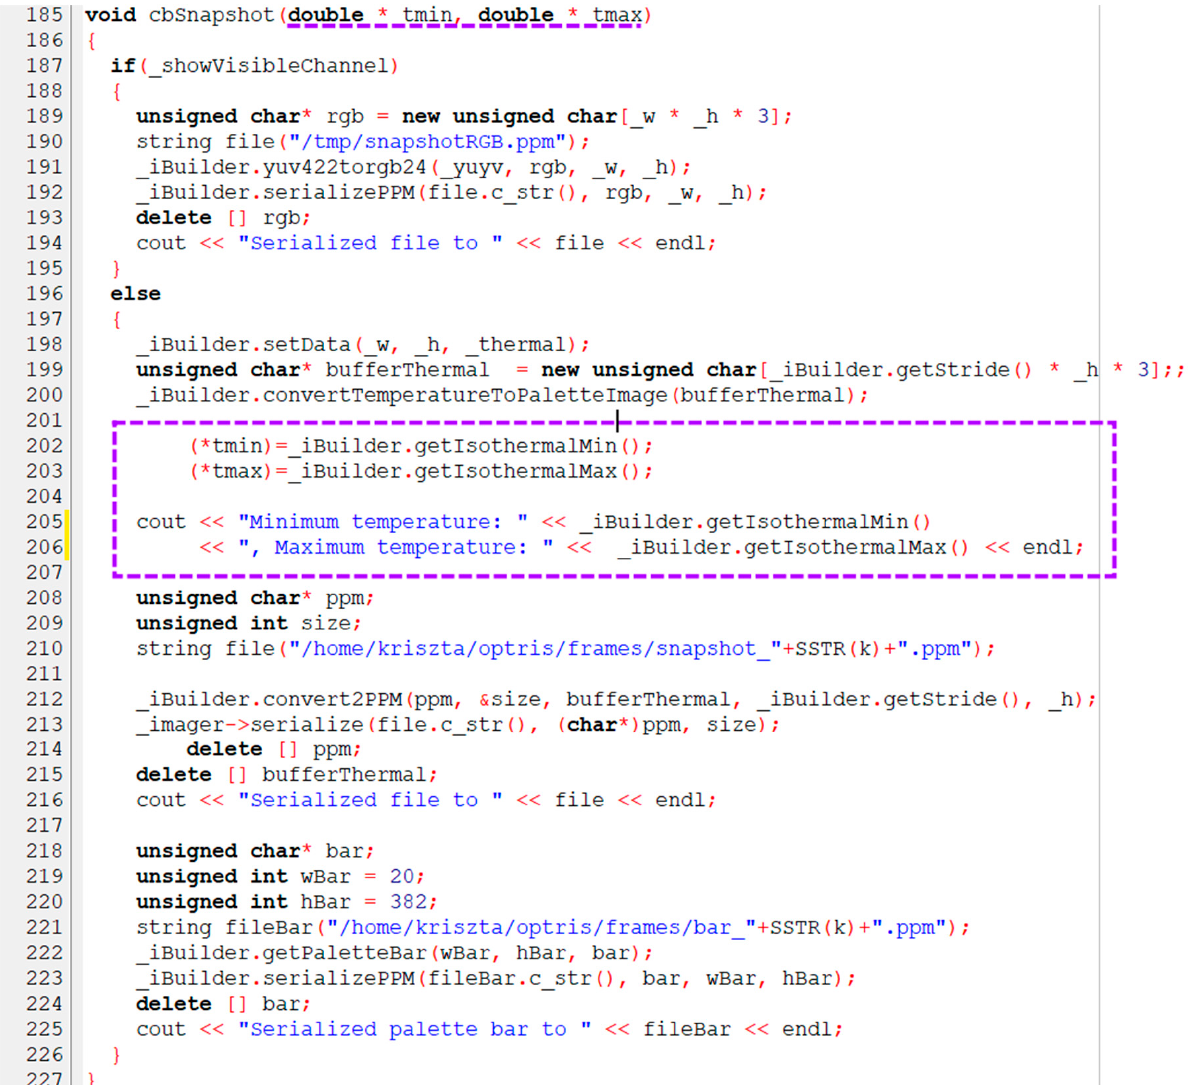
Figure A1. Controlling script of the thermal imaging system, part 1: modification of the cbSnapshot() function. The purple dashed frame and a purple line highlights the inserted parts.